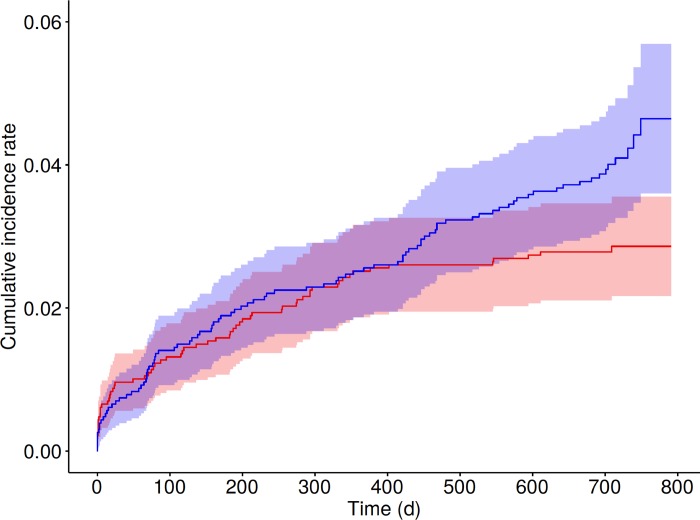
Cumulative incidence curves with 95% confidence bands for the competing events of non-CABG major bleeding (red) and thrombotic event (blue) in all 2,291 patients.CABG, coronary artery bypass graft.